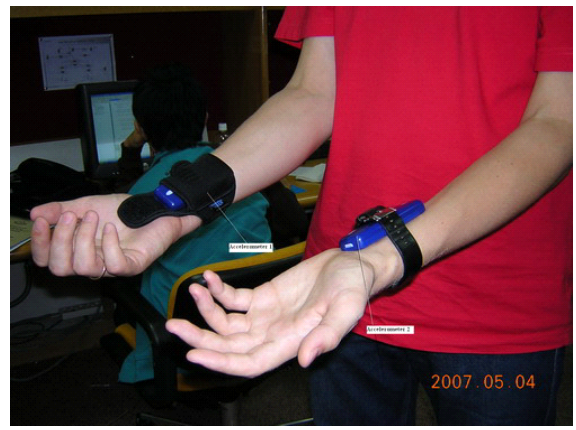
Figure 5. The experiment with 3 axis accelerometer.